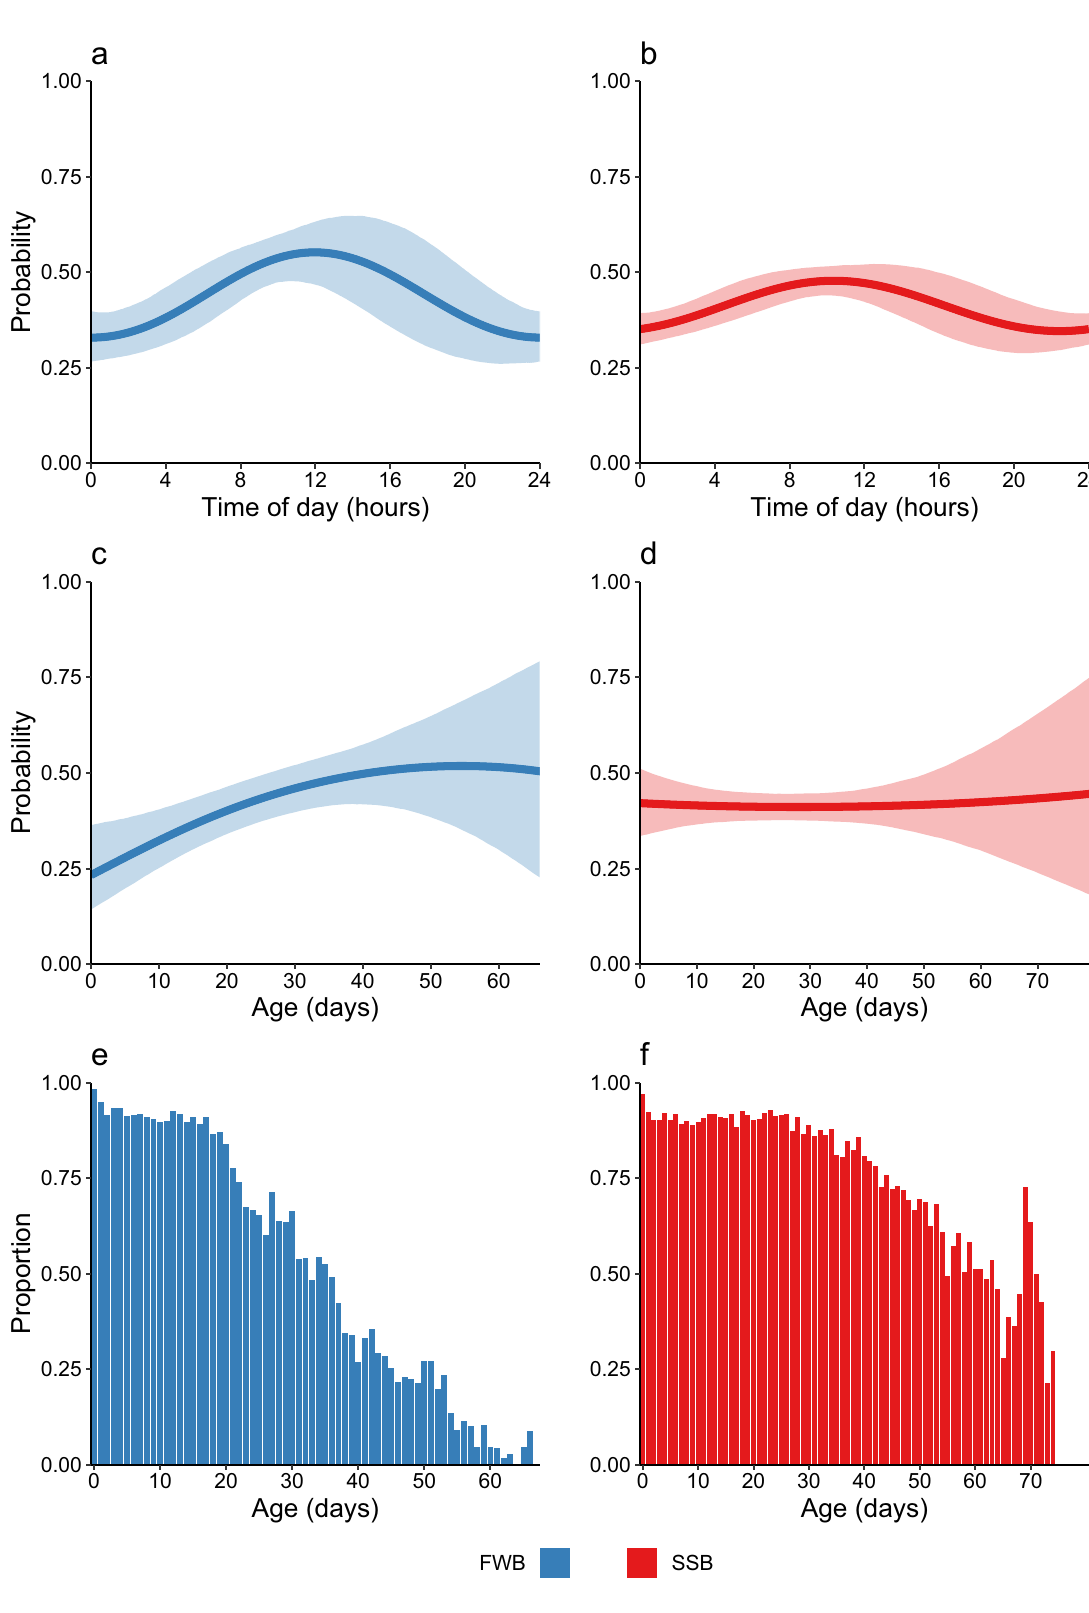
Figure 3. Main results of the HMM. ( a – d ) Mean probability (± 95% confidence interval) of being in an ‘active’ behavioural state as a function of the covariates included in the HMM. Probabilities were calculated for each covariate and state by fixing the other covariates to their respective means or reference categories. Confidence intervals for the probabilities were obtained based on Monte Carlo simulation from the estimators’ approximate distribution as implied by maximum likelihood theory. ( a , b ) The probability of being in an active state as a function of time. ( c , d ) The probability of being in an active state as a function of age. ( e , f ) The proportion of time pups spent at their colony of birth or elsewhere on the